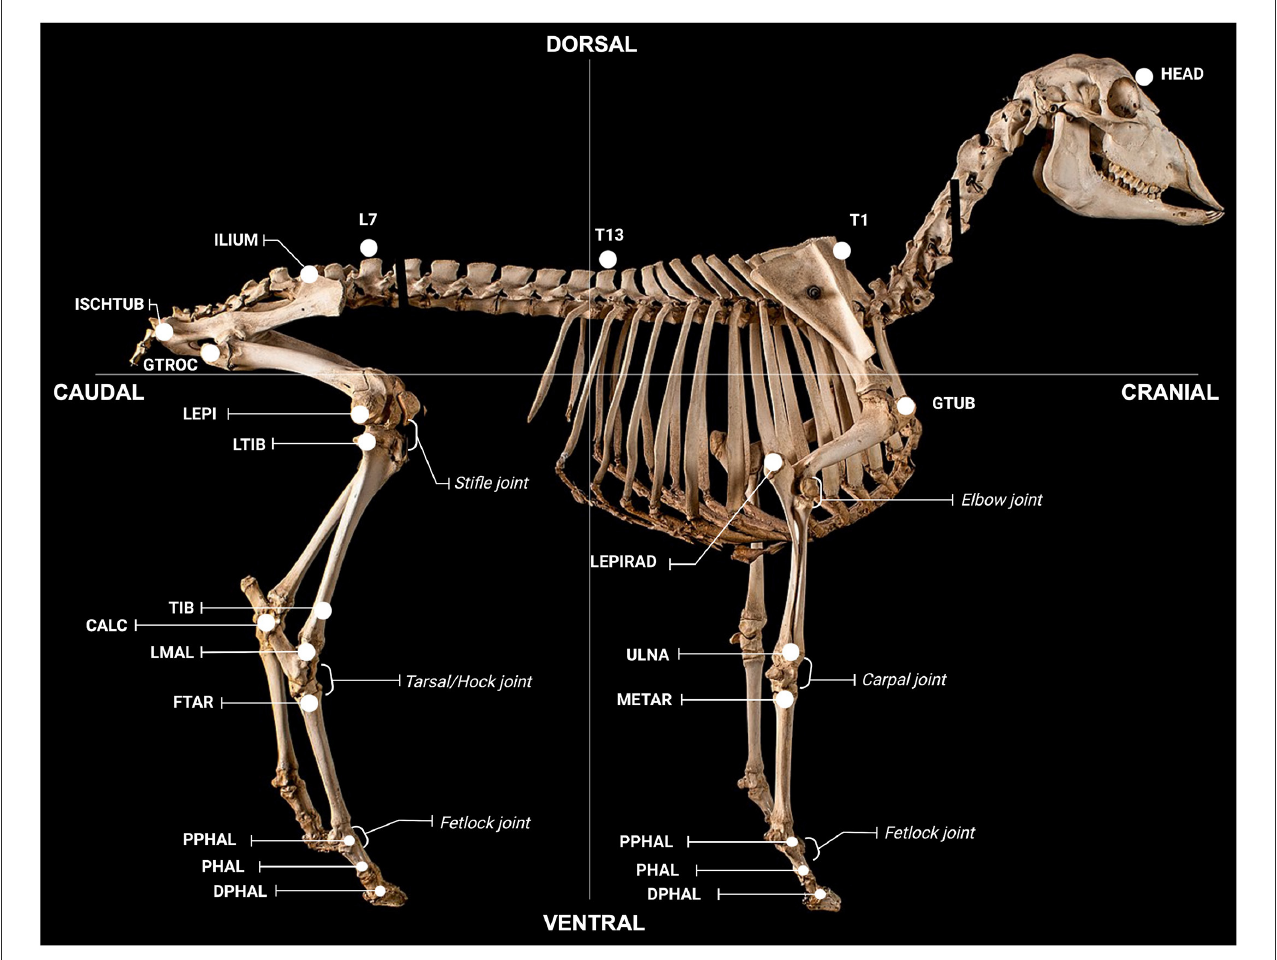
FIGURE2 Anatomical locations for gait assessment. Locations were defined as follows; global : HEAD (on the head between the eyes), T1 (spinous process of T1), T13 (spinous process of T13), L7 (spinous process of L7); forelimb : GTUB, greater tubercle of the humerus; LEPIRAD, lateral epicondyle of the radius; ULNA, distal tubercule of the ulna; METAR, proximal tubercule of the metatarsal; PPHAL, forelimb proximal phalange; PHAL, forelimb phalange; DPHAL, forelimb distal phalange; hindlimb : ILIUM, iliac crest; ISCHTUB, ischial tuberosity; GTROC, greater trochanter of the femur; LEPI, lateral epicondyle of the femur; LTIB, lateral condyle of the tibia; TIB, tibia; CALC, calcaneus; LMAL, lateral malleolus; FTAR, fused tarsal of the metacarpus; PPHAL, hindlimb proximal phalange; PHAL, hindlimb phalange; DPHAL, hindlimb distal phalange. The METAR/FTAR, PPHAL, and PHAL were used to determine the fetlock angle of the fore and hind limbs respectively. The LEPIRAD, ULNA, METAR, and PPHAL and the TIB, LMAL, FTAR and PPHAL, were used to determine the angle of the carpus and tarsus, respectively. The GTUB, LEPIRAD, and ULNA and the GTROC, LEPI, LTIB, and LMAL were used to determine the angle of the elbow and stifle, respectively. Retro-reflective markers attached to each location were 15mm in diameter, except for markers on the fore- and hind-limb PHAL, PHAL and DPHAL, which were 9mm. Figure adapted from a sheep skeleton on display at the Museum of Veterinary Anatomy, Faculty